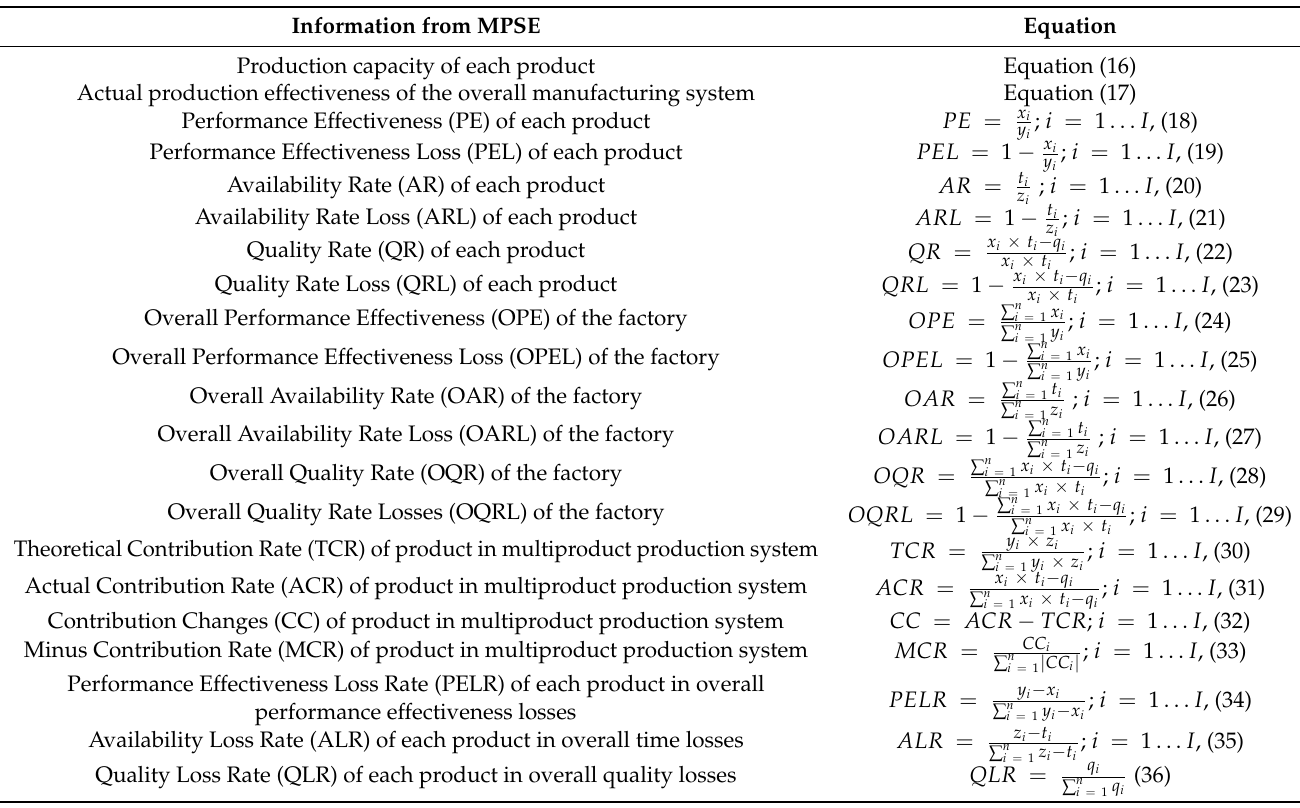
Table 3. Information derived from multiproduct production system effectiveness